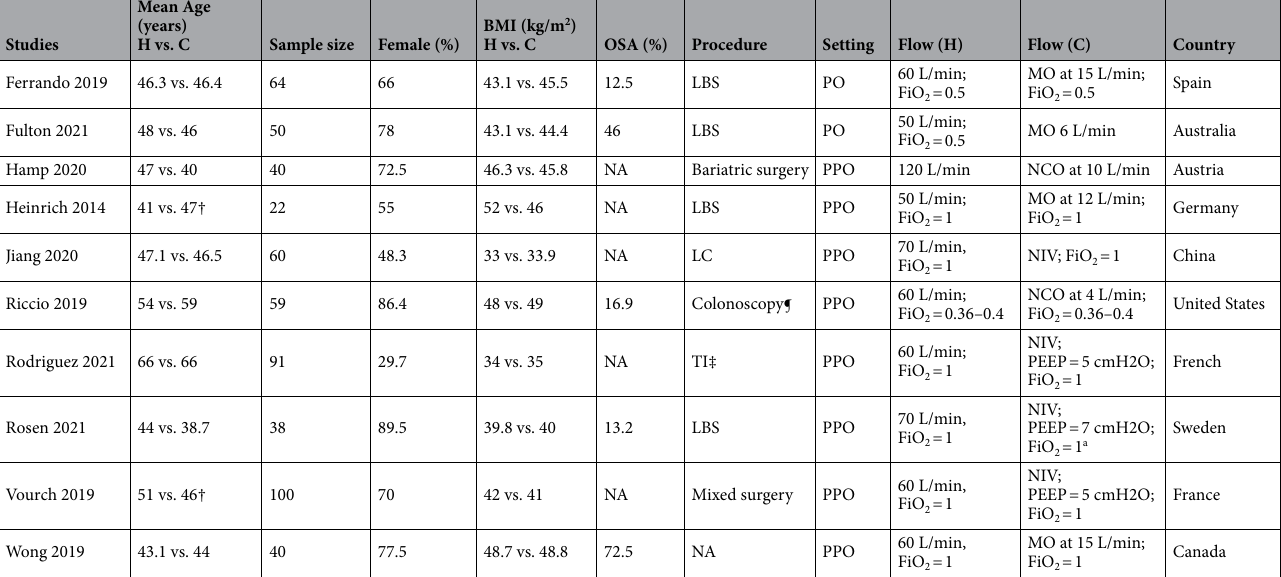
Table 1. Characteristics of included studies (n = 10). H high-flow nasao oxygenation group, C control group, vs. C †data were presented as median, LBS laparoscopic bariatric surgery, ¶ procedure was performed under deep sedation, MO mask oxygenation, FiO 2 fraction of inspired oxygen, NCO nasal cannula oxygenation, MV mask ventilation, BMI body mass index, TI tracheal intubation, ‡ performed in intensive care units, PO